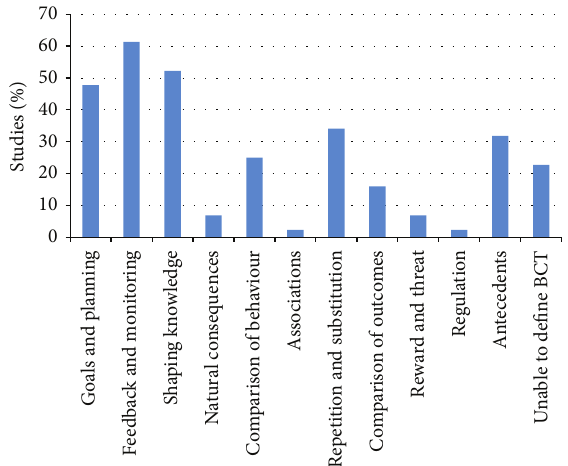
Figure 1: Behaviour change technique taxonomy categories of the interventions in included studies ( 𝑛 = 44 studies).